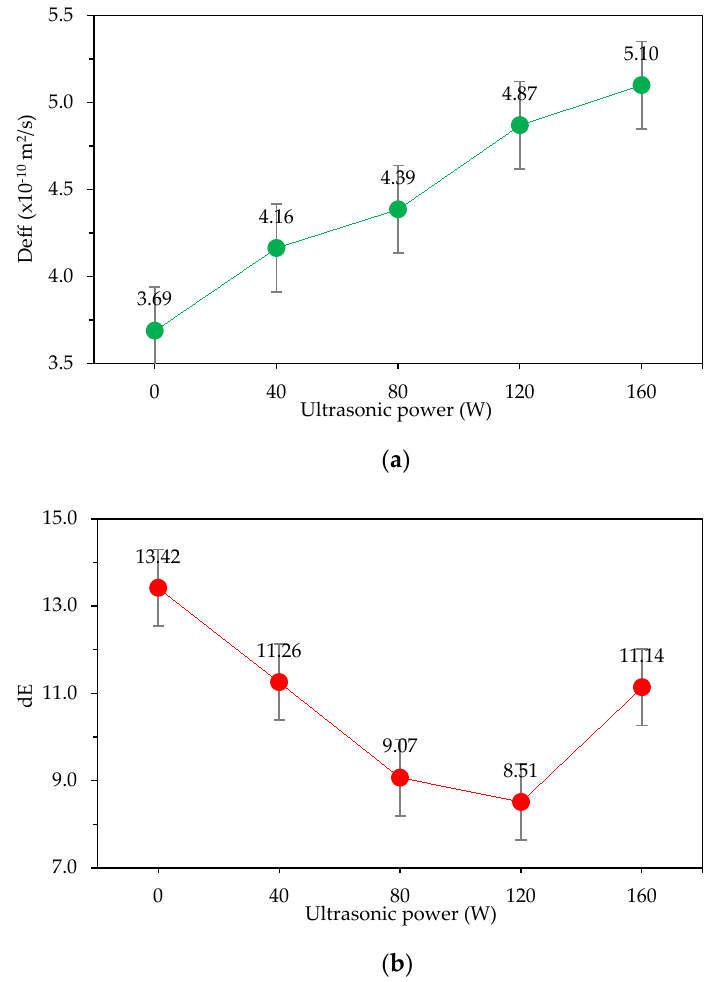
Figure 7. Effect of ultrasonic power on ( a ) moisture diffusion coefficient and ( b ) color change.